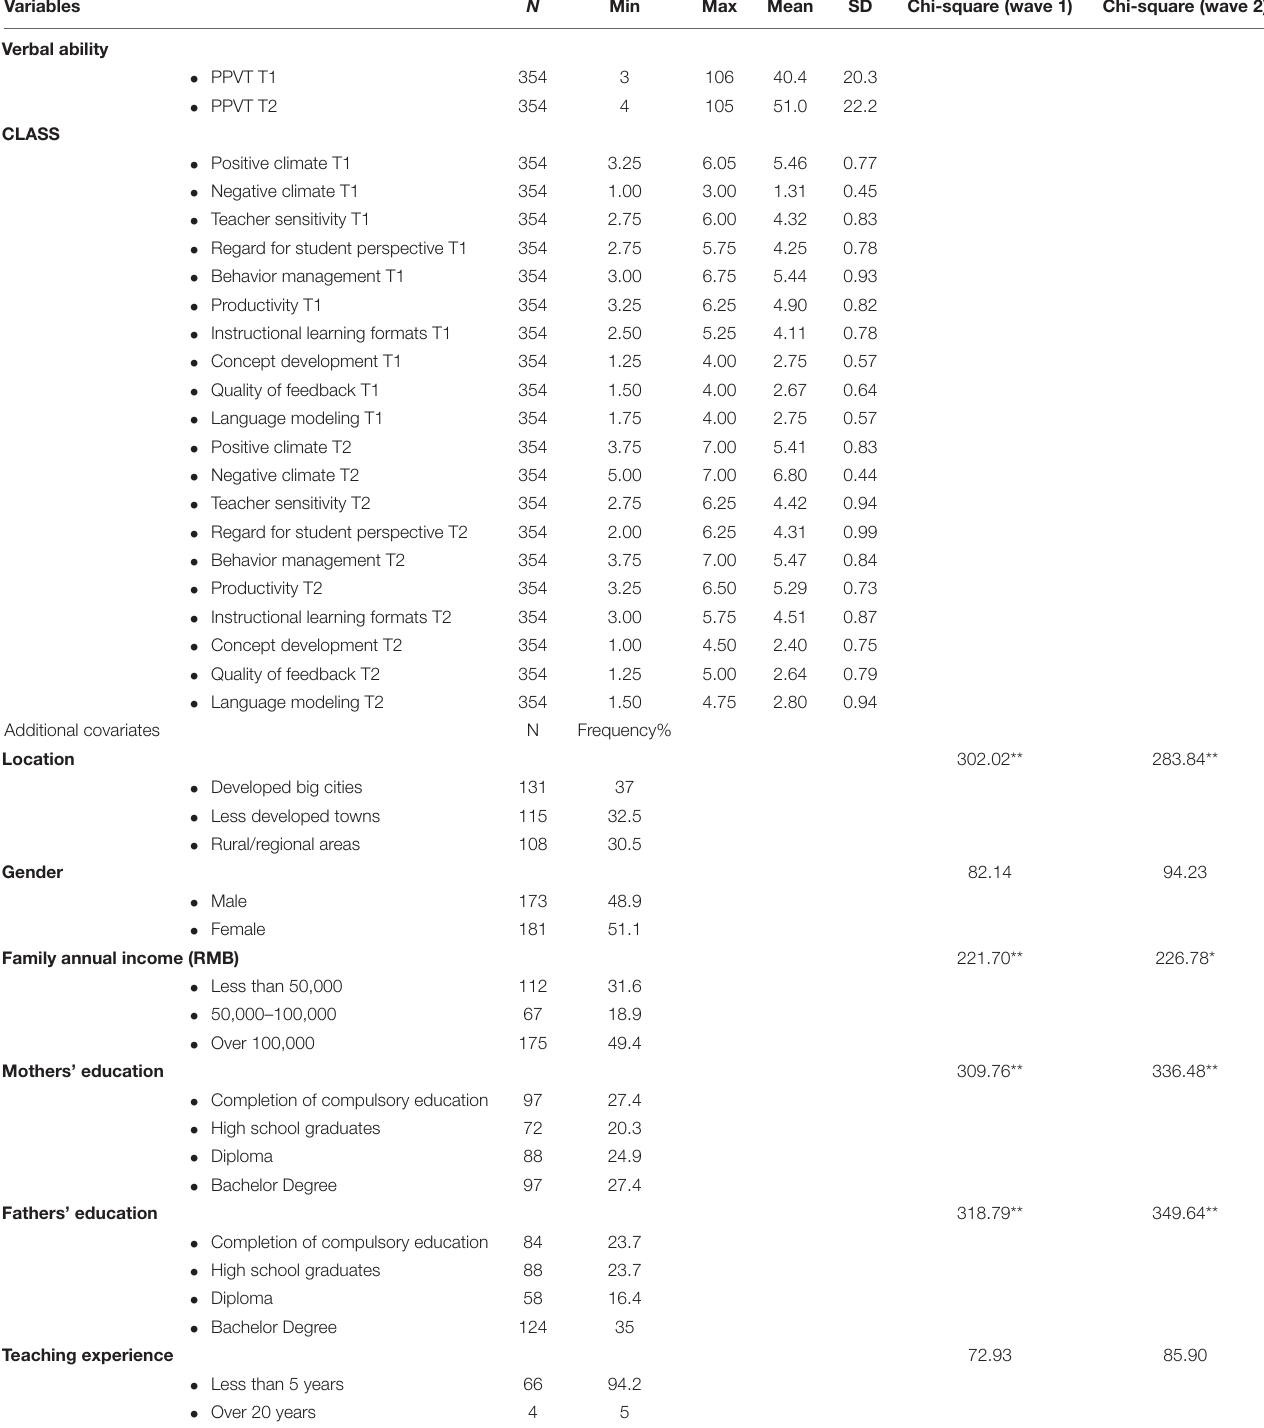
TABLE 1 | Descriptive statistics of the